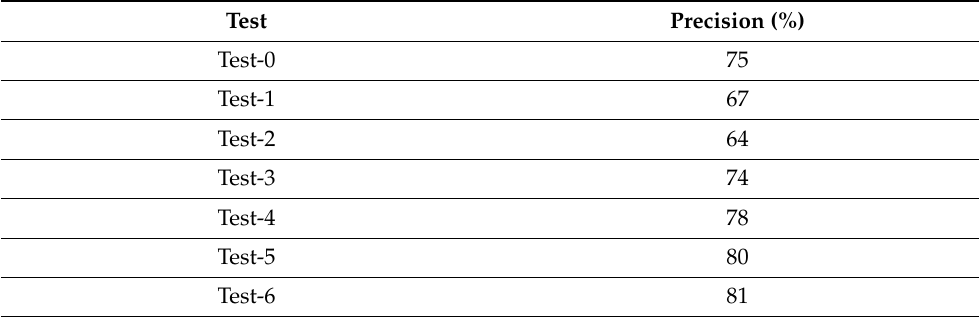
Table 6. Accuracy and error obtained in each of the